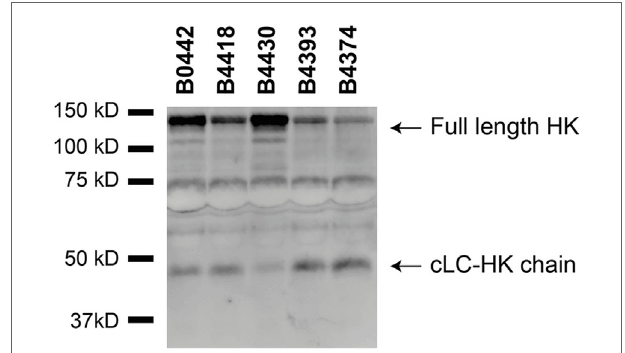
FigUre 5 | Various Bordetella pertussis strains activate the contact system. Contact system activation by B. pertussis strains B0442, B4418, B4430, B4393, and B4374 was shown by immunoblot. 50% plasma was incubated for 60 min with the B. pertussis strains (2 × 10 9 CFU) and analyzed using anti-high-molecular-weight-kininogen (HK). Incubation with all the B. pertussis strains resulted in cleavage of the ~120 kDa full length HK as indicated by the appearance of the ~46 kDa cLC-HK